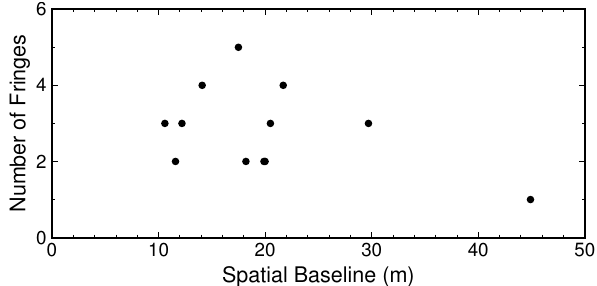
Figure 8. Relationship between the number of fringes and the spatial